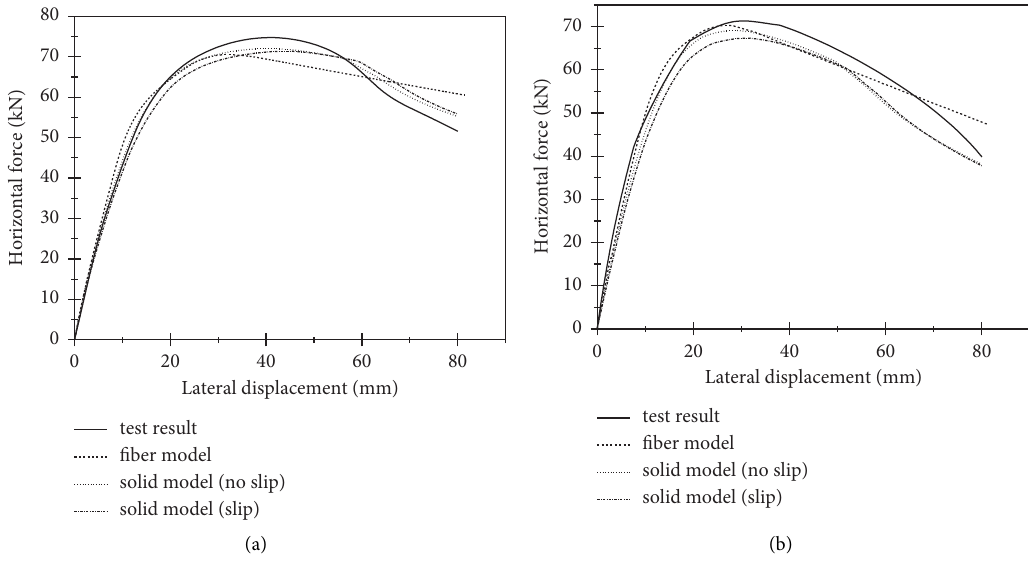
Figure 4: Comparison of calculated result with the test result. (a) CF-11. (b)